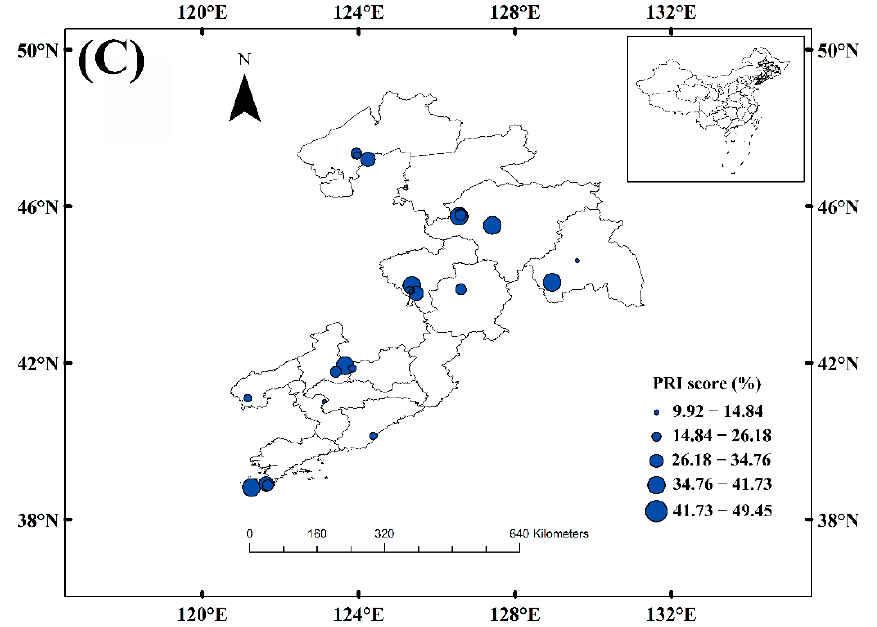
Figure 1. Spatial distributions of facial expression scores for happy ( A ) and sad emotions ( B ) and net positive emotion (positive response index, PRI) ( C ) for visitors in different genders and ages at parks in Northeast China.